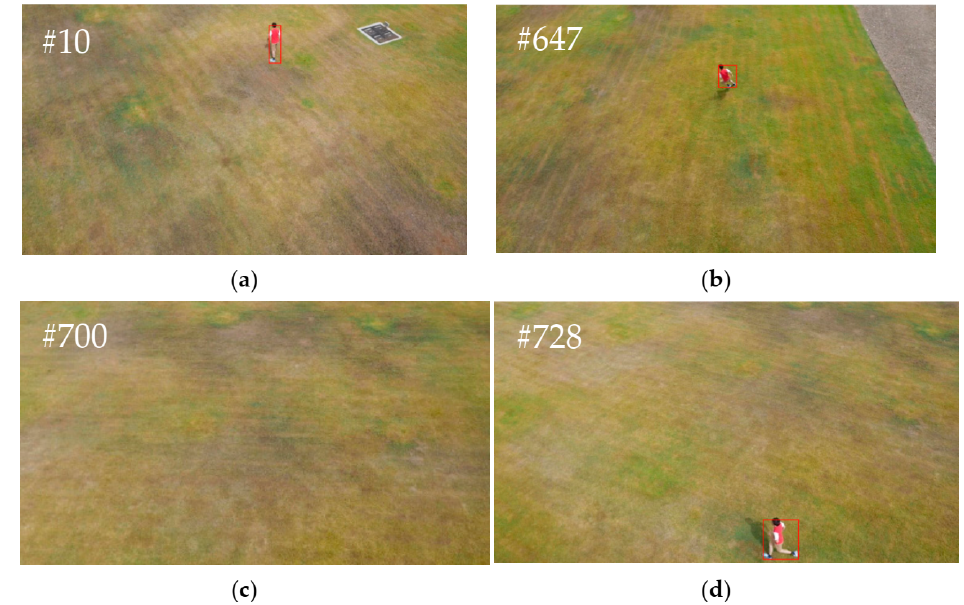
Figure 12. UAV123 datasets tracking test of person7. ( a ) Object in its initial state; ( b ) object in a rolling movement; ( c ) object exiting the line of sight; ( d ) object reentering the line of